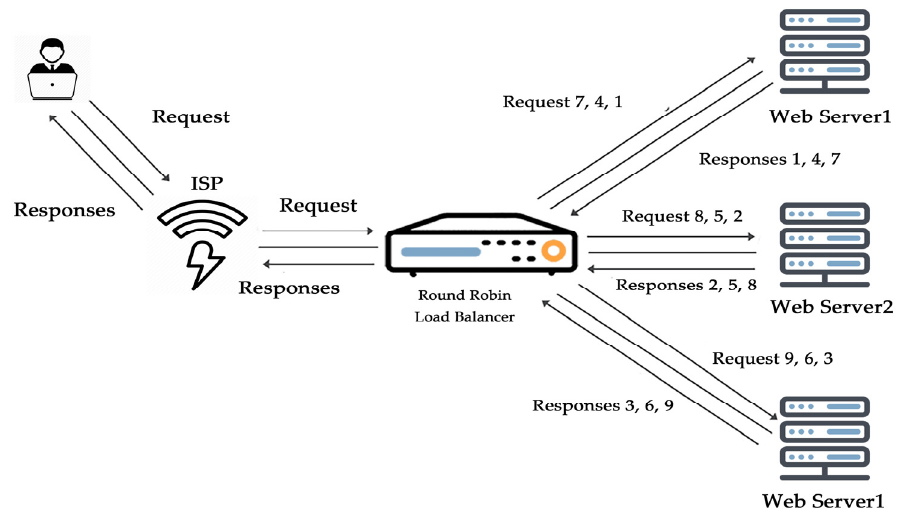
Figure 1. Round robin algorithm.